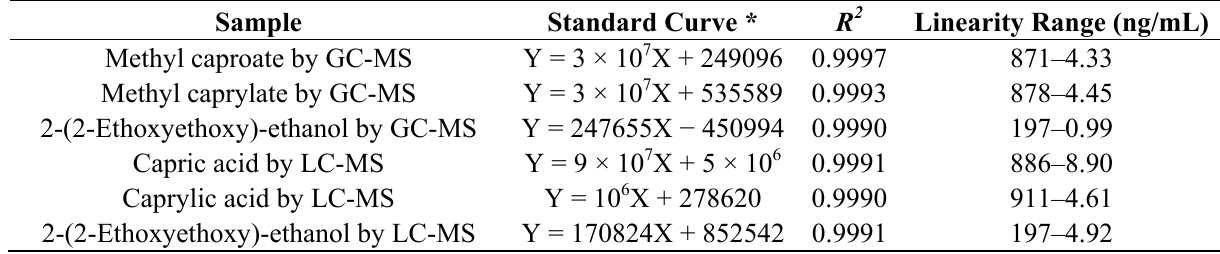
Table 3. Standard curves and linearity ranges of Labrasol ® and Transcutol ® analyses using GC-MS and